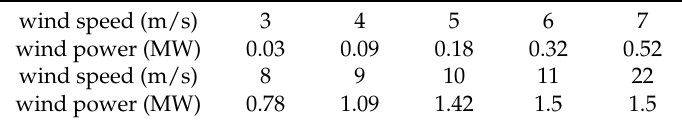
Table 3. The relationship between wind speed and wind power.